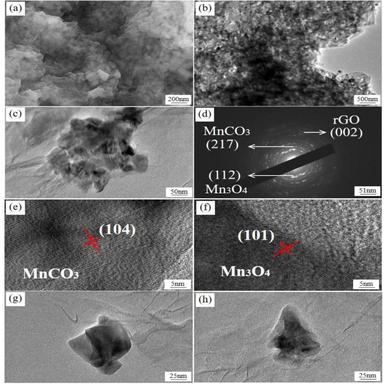
(a) SEM image, (b) TEM image, (c, e, f, g and h) HRTEM images, (d) SAED pattern of the graphene-wrapped MnCO3/Mn3O4 nanocomposite.